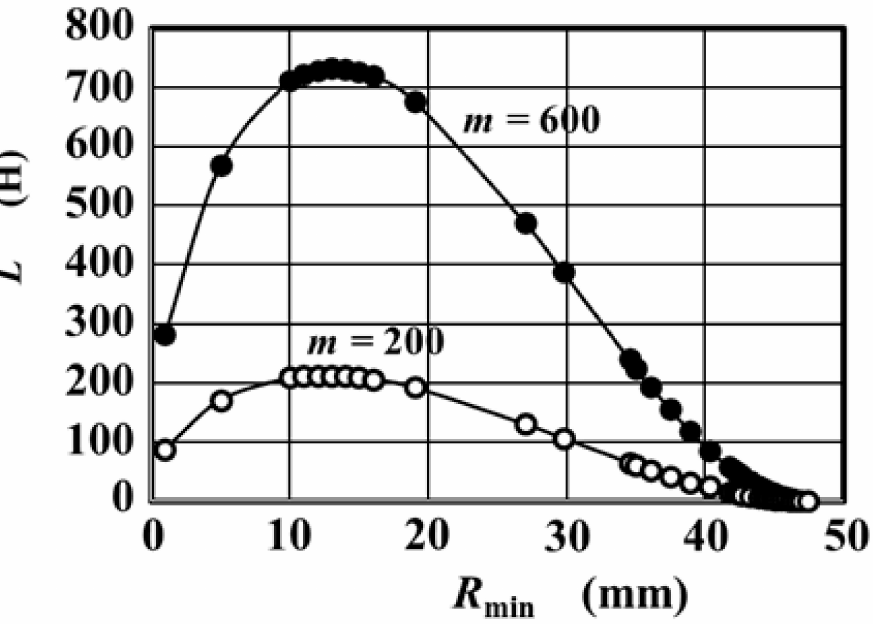
Figure 15. Dependence of L on R min for the cases of m = 600 and m = 200.